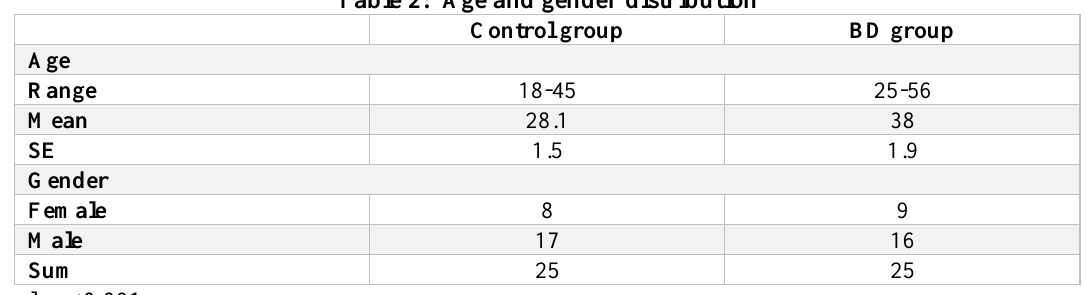
Table 3: Clinical Manifestation of Behçet’s disease Cases